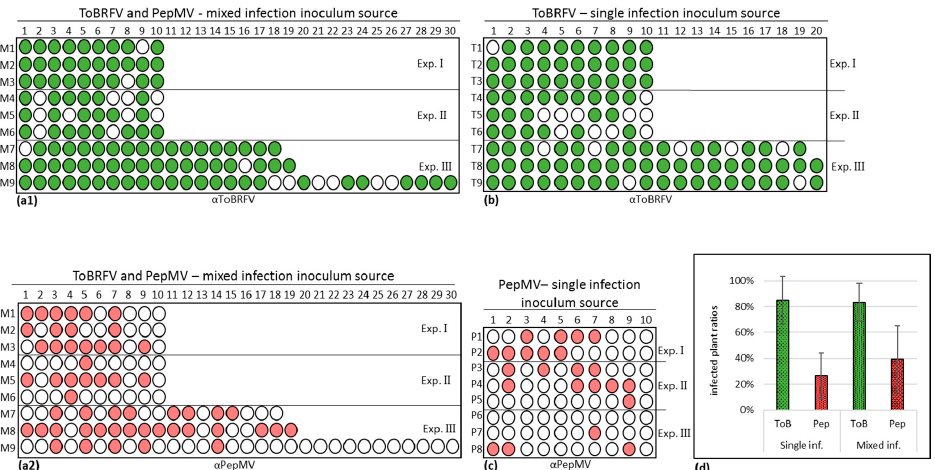
Figure 2. Enhanced severity of symptom development in tomato brown rugose fruit virus (ToBRFV) and pepino mosaic virus (PepMV) mixed-inoculated tomato plants compared to singly inoculated plants. ( a ) A graphical depiction of mean percent symptomatic leaves in each of three tomato plant cultivars: Zohara, Shiran and Ikram either singly inoculated with ToBRFV or PepMV, or co-inoculated with a mixture of the viruses. The various leaf manifestations are color coded. A green color indicates healthy leaves; a yellow color with green slanted stripes indicates mosaic yellowing leaves; a bright orange color with vertical stripes indicates mosaic serrated leaves; a dark orange color with vertical stripes indicates a shoestring-like phenotype. ( b ) Shoestring-like leaves. ( c ) Mosaic serrated leaves. ( d ) Mosaic yellowing leaves.